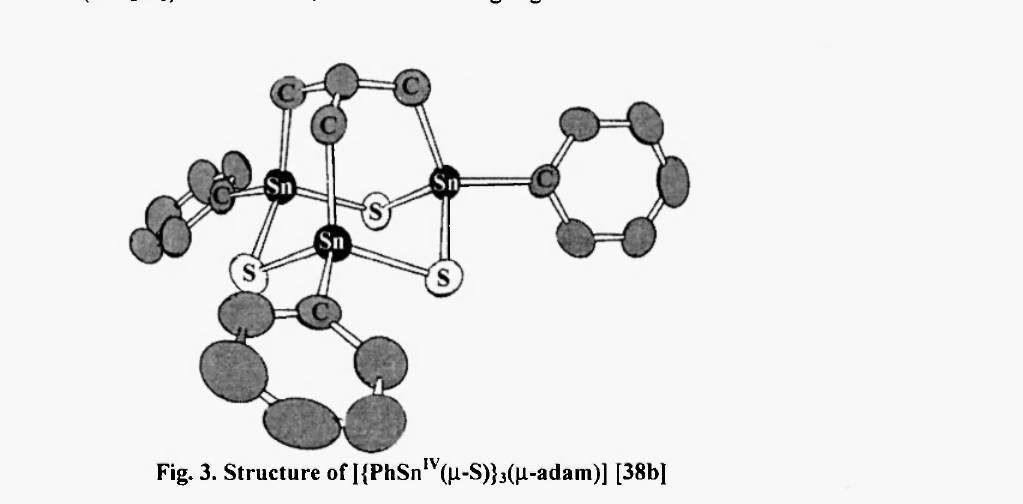
Fig. 3. Structure of |{PhSn Iv ^-S)} 3 ^-adam)]